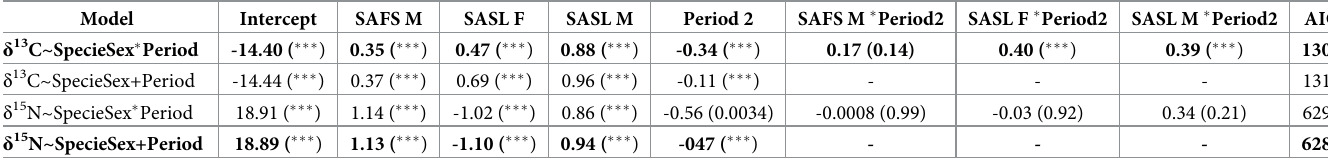
Table 2. Linear Mixed-Effects Models (LMM) for δ 13 C and δ 15 N values. Model